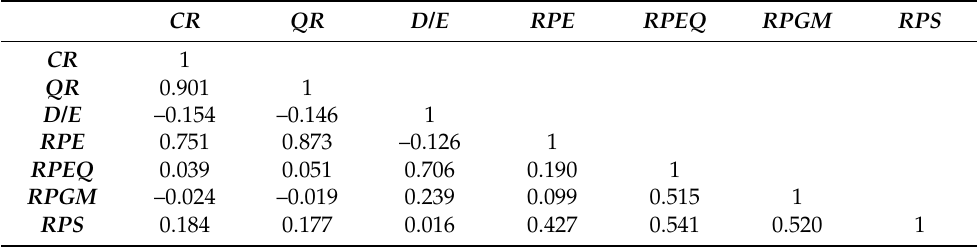
Table 6. Correlation matrix for electricity